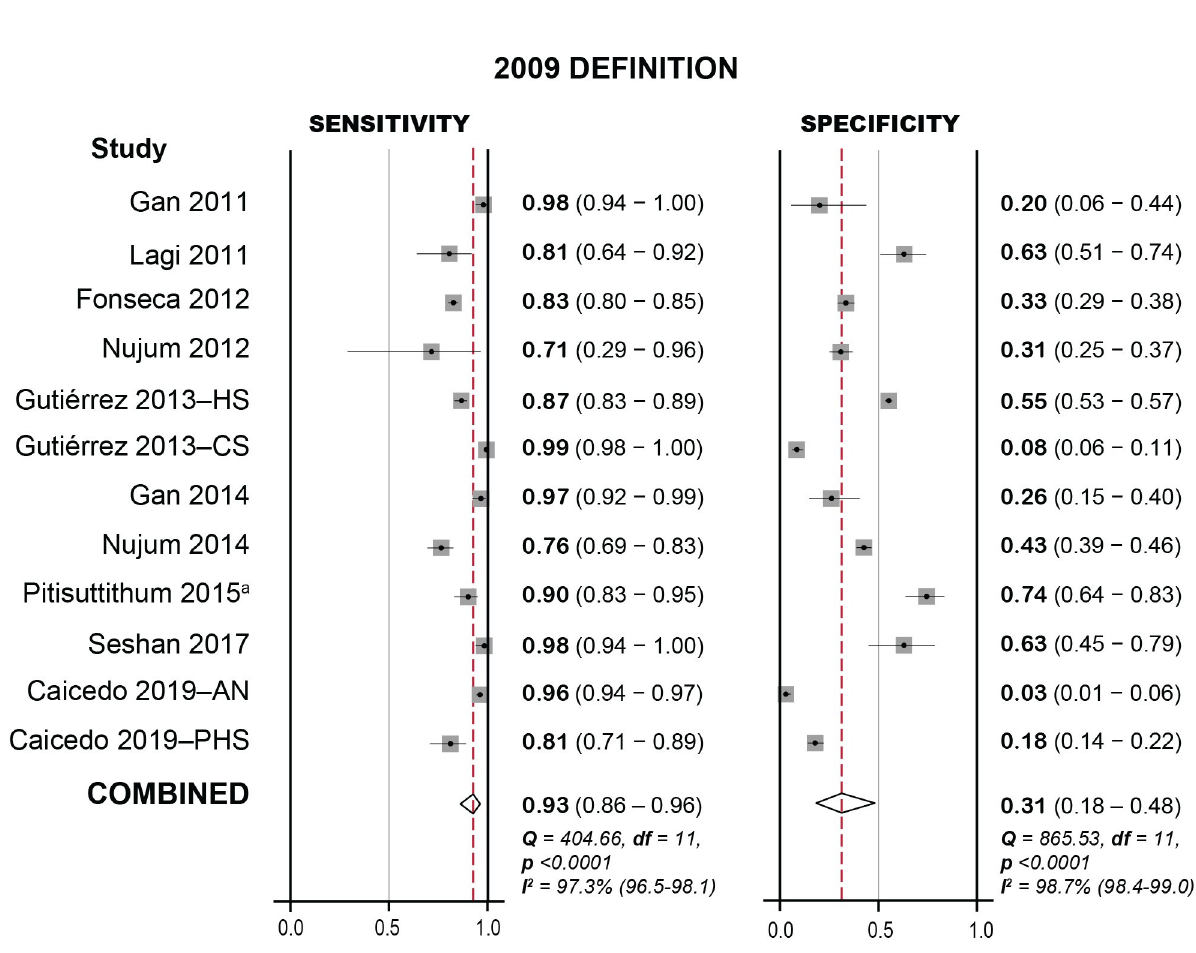
Table 5. Sensitivity and specificity from studies that modified WHO clinical criteria for dengue diagnosis.